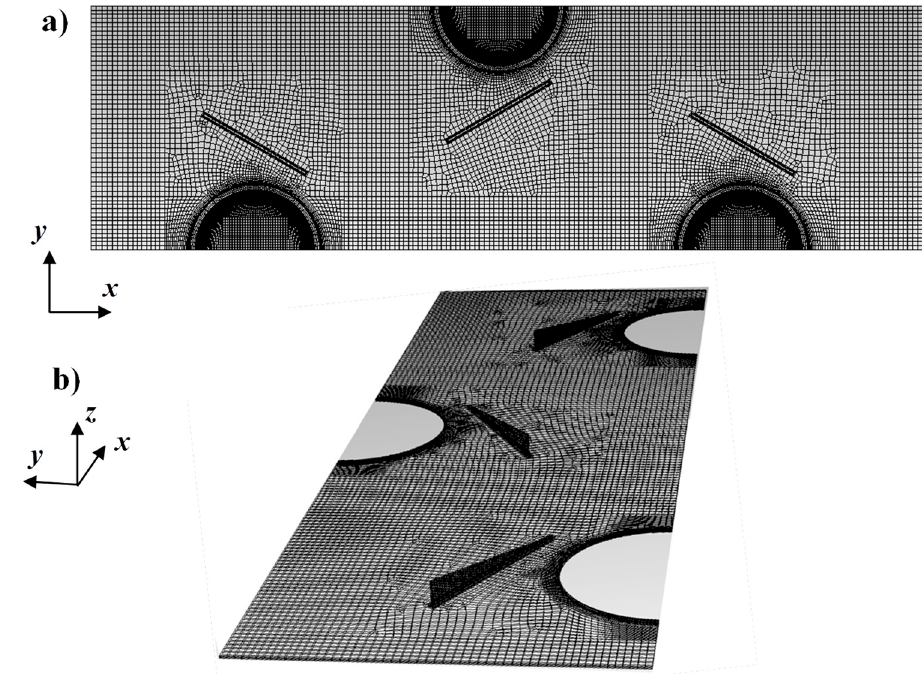
Figure 6. Schematic view of generated mesh: ( a ) top view and ( b ) 3D mesh system of fin surface with vortex generators in DWD configuration.